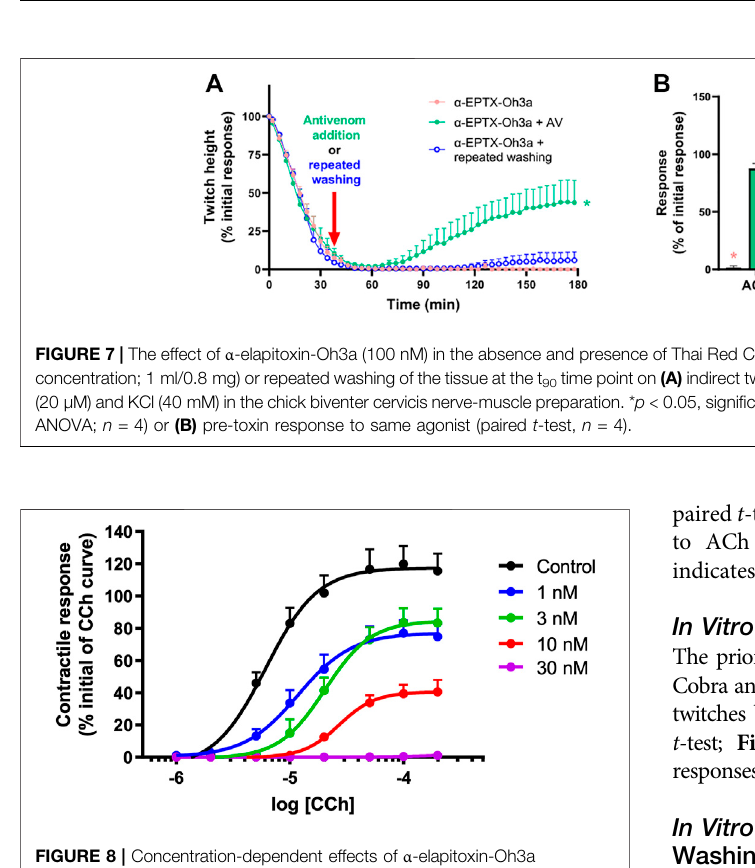
Frontiers in Pharmacology |